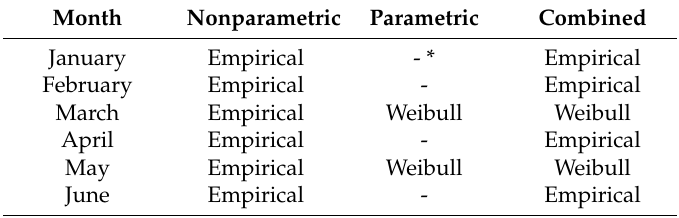
Table 2. Probability distribution of the CFs under three different scenarios of the